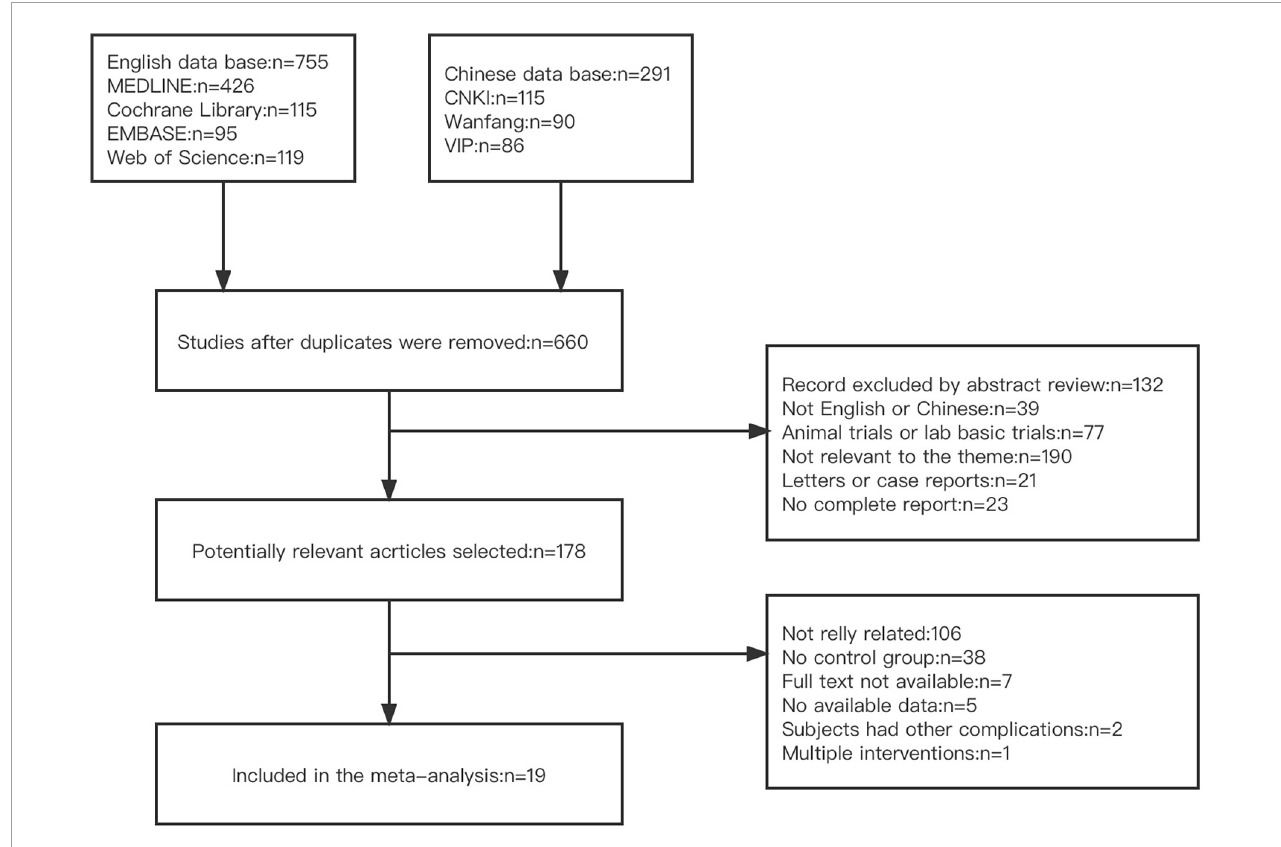
FIGURE1 Flow diagram of screening literature